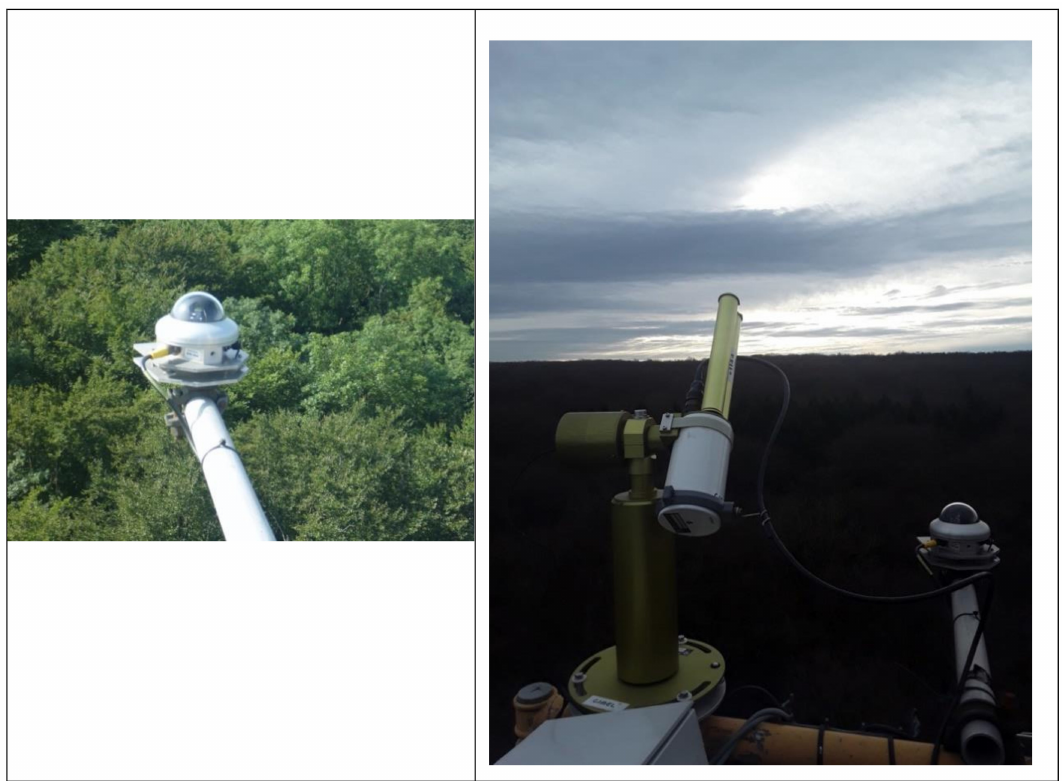
Figure 2. Photos taken at the Hainich FLUXNET tower site, and configuration of the albedometer (and AErosol RObotic NETwork (AERONET) CIMEL sun photometer. Courtesy of Frank Tindemann (left) and Lukas Siebicke (right), Universität Göttingen.